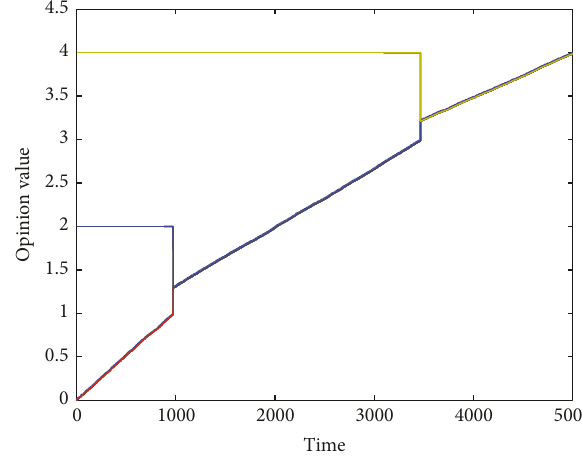
Figure 3: Opinion evolution of system (2)–(5) of 20 agents with noise uniformly distributed on [0,0.02]𝜖 . The initial opinion value 𝑥(0) = [0 0 0 0 0 0 0 0 0 0 2 2 2 2 2 4 4 4 4 4] , confidence threshold 𝜖 = 1 , and noise strength 𝛿 = 0.02